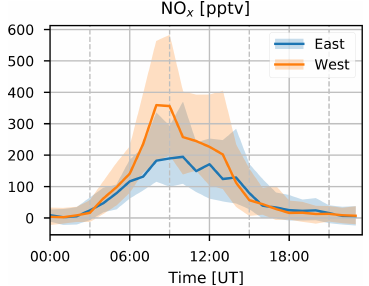
Figure 13. The median diel profile of hourly averaged NO x con- centrations (pptv) along the wind directions according to measure- ments (blue for eastern transport and orange for western transport), recorded at the Maïdo observatory in 2018. Interquartile ranges are visualized by the shaded area behind the